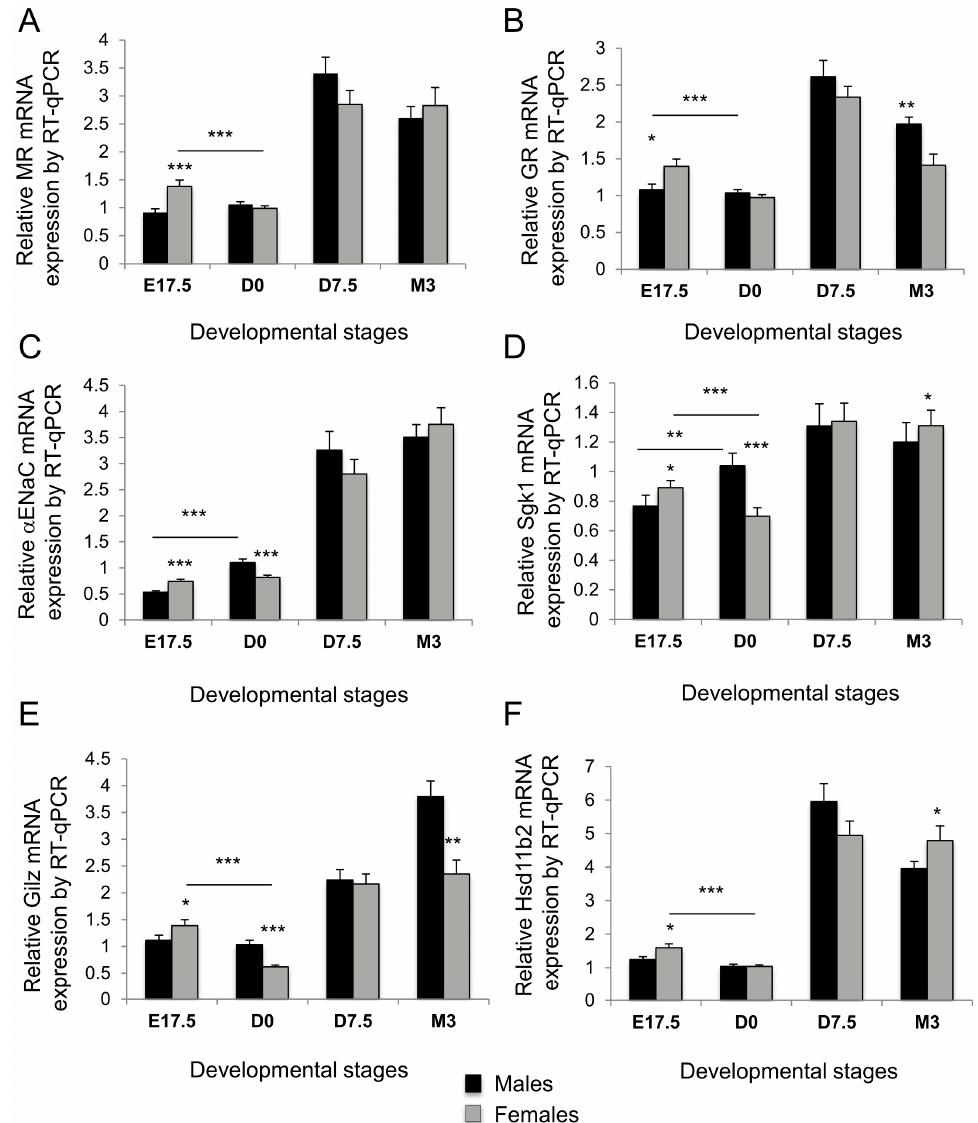
Figure 2. Sexual dimorphism in mineralocorticoid receptors (MRs), glucocorticoid receptor (GRs), Hsd11b2 and several MR-regulated target gene expressions during renal development in mice. MRs ( A ); GRs ( B ); α subunit of the epithelial sodium channel ( α ENaC ) ( C ); serum and glucocorticoid-regulated kinase 1 ( Sgk1 ) ( D ); glucocorticoid-induced leucine zipper protein ( Gilz ) ( E ); and Hsd11b2 ( F ) renal relative mRNA expressions throughout development in mice were determined using reverse transcription quantitative PCR (RT-qPCR) at various developmental stages as follows: 17.5 days of gestation (E17.5), day of birth (D0), D7.5 and M3. E: Embryonic day, D: postnatal day, M: postnatal month. Results, expressed as the ratio of attomoles of specific gene per femtomoles of ribosomal 18S, normalized to the expression of male mice at D0, arbitrarily set at 1, correspond to mean ± SEM of three independent experiments comprising at least 6 male and 6 female kidneys each. * p < 0.05, ** p < 0.01, *** p < 0.001. Note that statistical significances between different developmental stages from D0 to D7.5 are not represented on the graph for better clarity, but for all p < 0.0001.